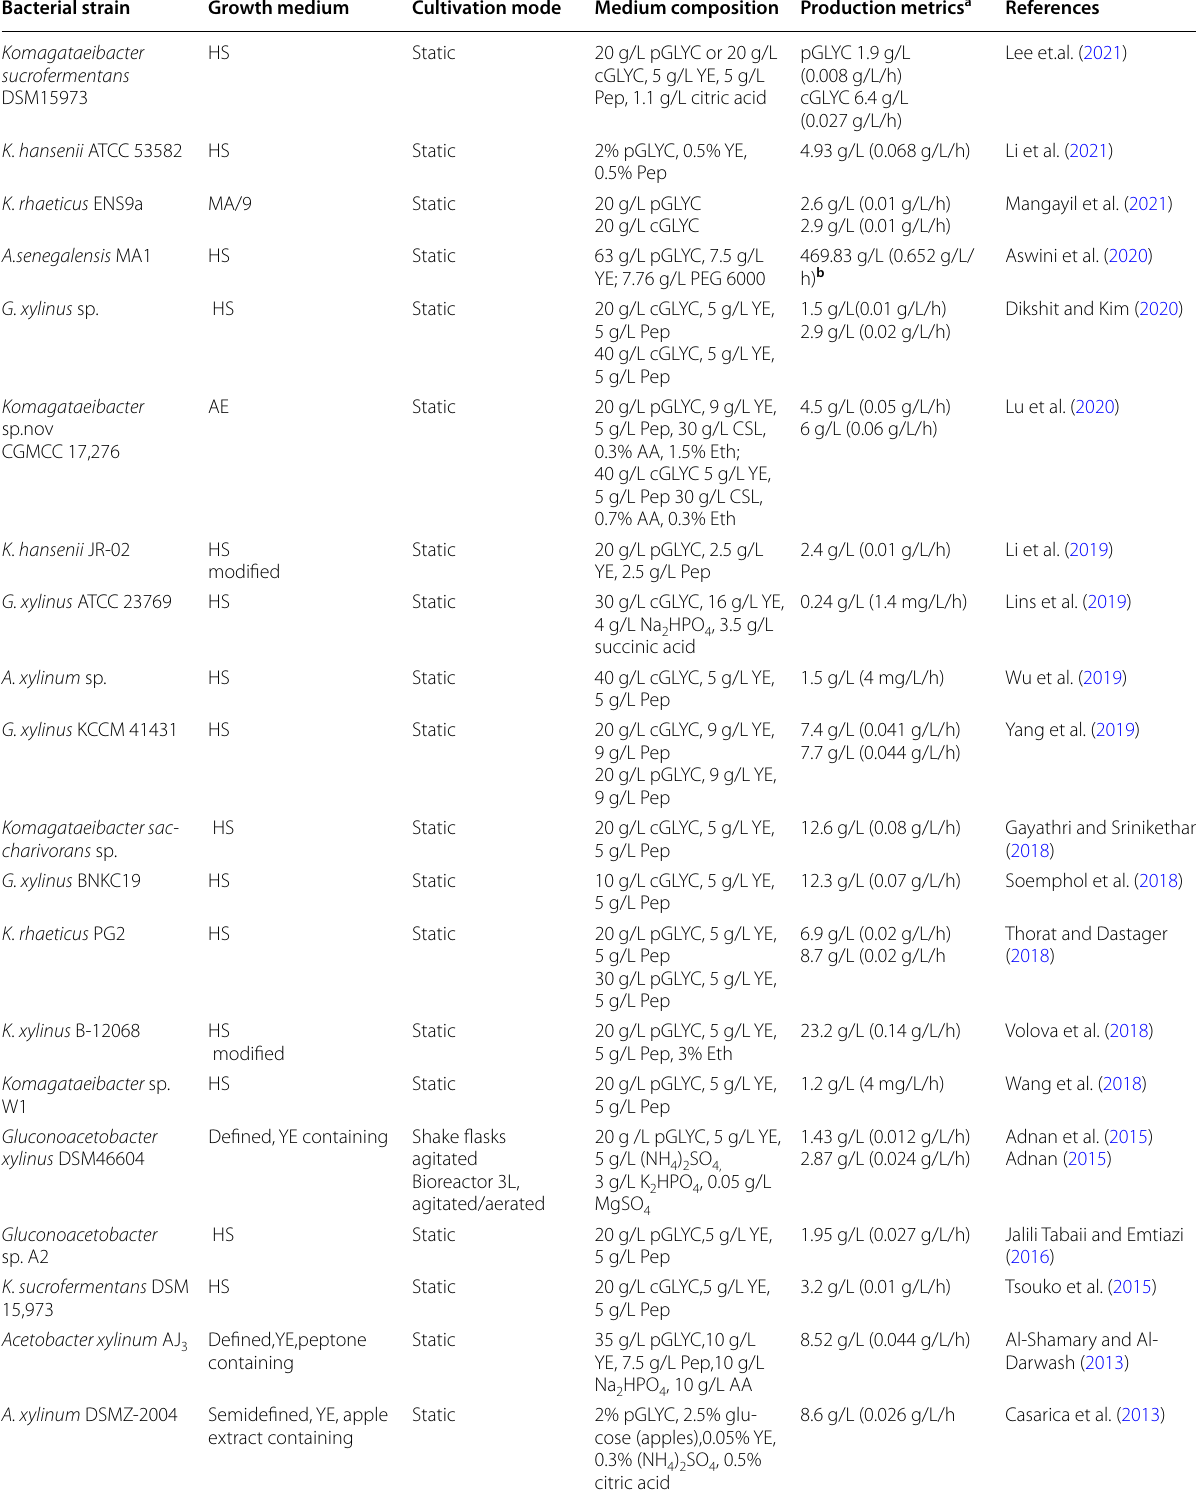
Table 1 Production of bacterial cellulose by acetic acid bacteria from pure or crude glycerol as the sole carbon source Bacterial